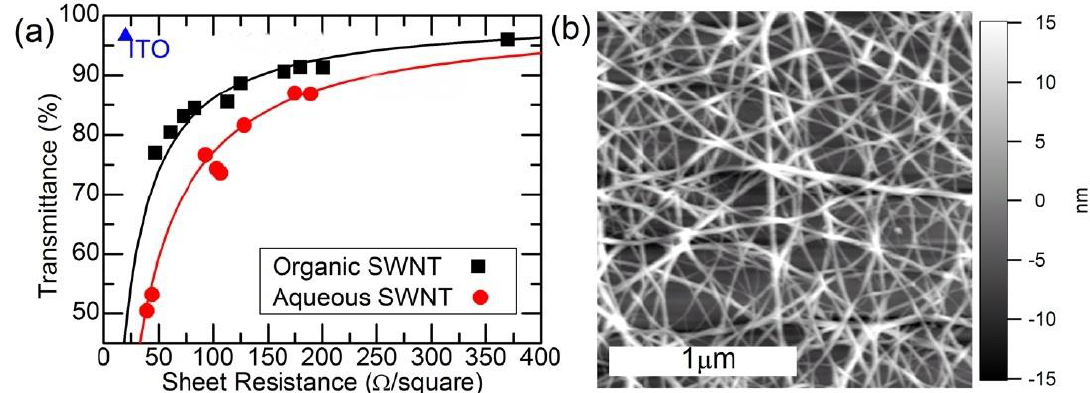
Figure 7. ( a ) Transmittance versus sheet resistance for single-walled carbon nanotube films processed from either an organic or an aqueous solution. At acceptable transmittances for liquid crystal-based devices (T > 90%), the sheet resistance of approximately R ≈200–300 Ω□ −1 falls far short of the requirements of R ≈10–20 Ω□ −1 . ( b ) SEM image of a typical carbon nanotube network film, which demonstrates a quite large roughness (Reproduced by permission from [100]).